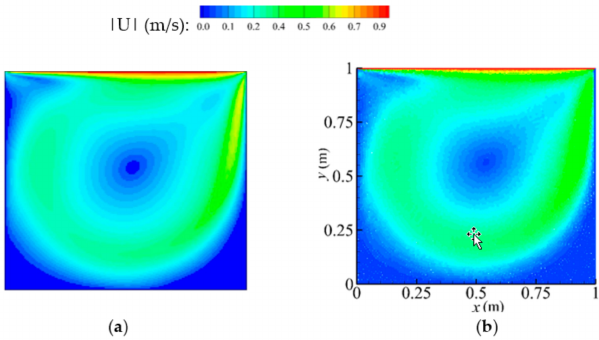
Figure 7. Vectorplotsoflid-drivenflowforthetwodifferentparticlenumbers: ( a ) N =1600; and( b ) N = 10,000. Red, location of fluid particle; Black, velocity of flow field.